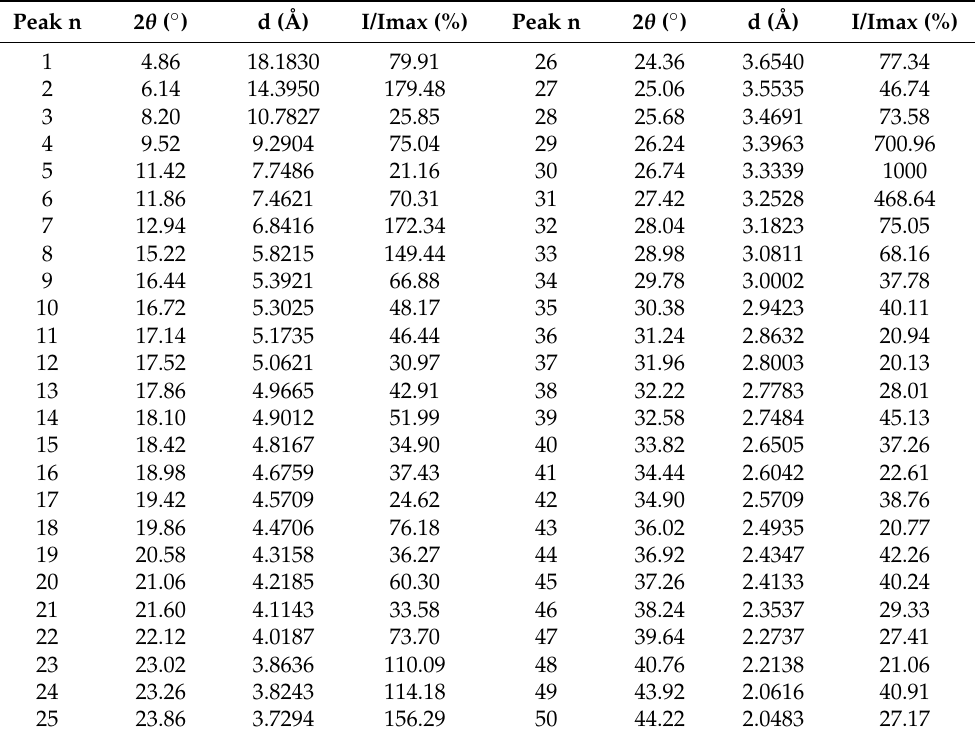
Table 8. PXRD data for the title compound III